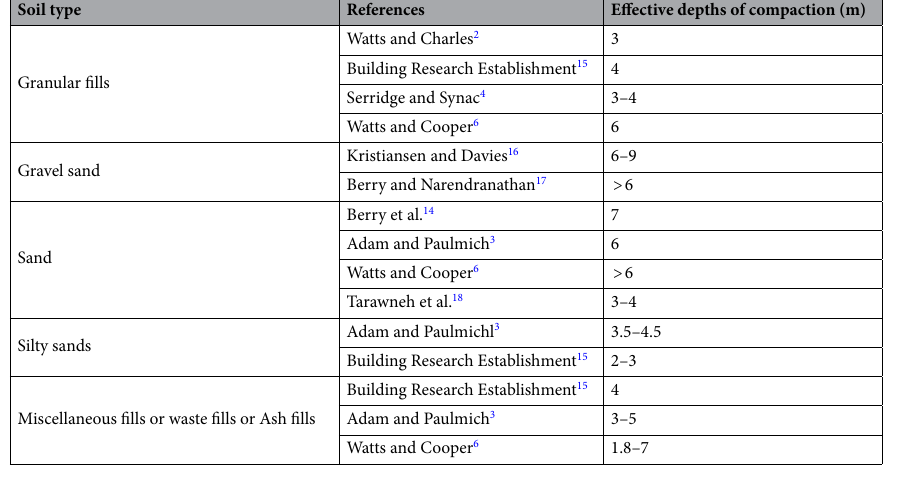
Table 1. Effective depths for the RIC compaction obtained in different